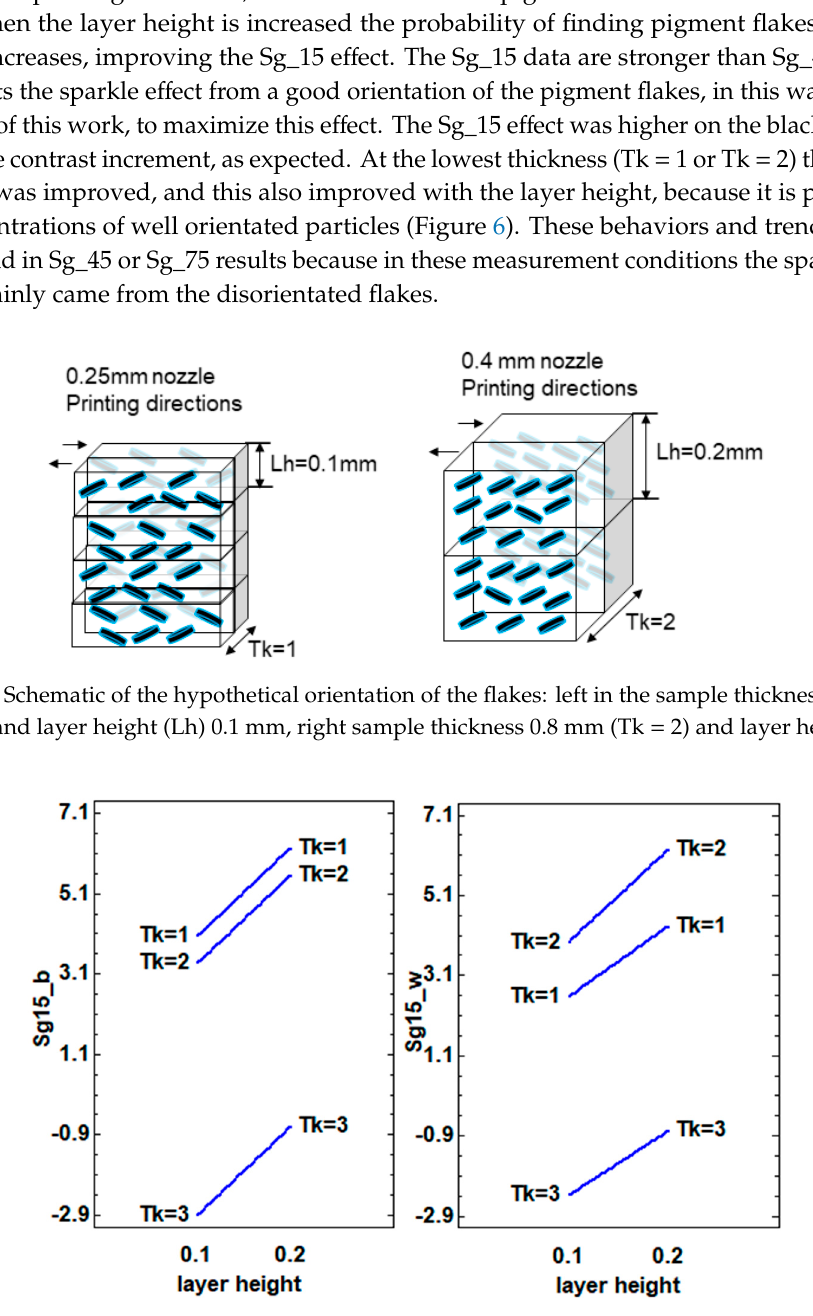
Figure 6. Interaction plots (layer height (B) and sample thickness (C) factors) for the sparkle values at 15° on white (_w) and black (_b) backgrounds.